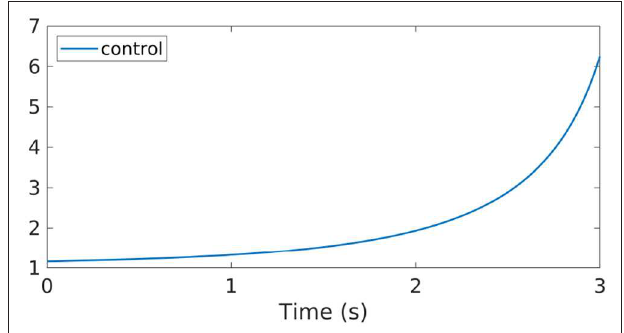
u obtained through the GD-RBM algorithm 10 oscillators. = b